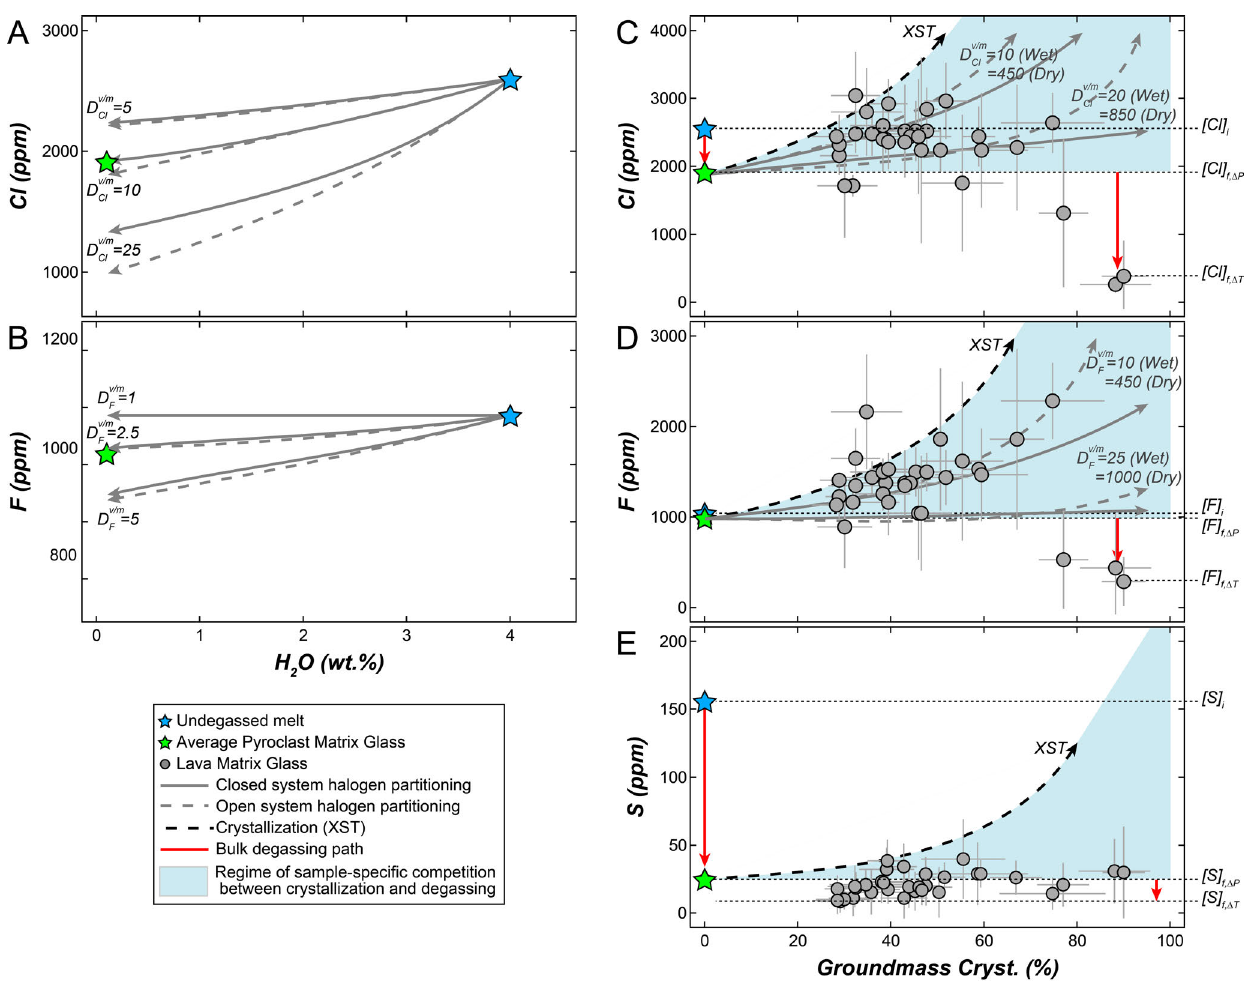
Figure 7: Devolatilisation of Cordón Caulle magma. [A–B] Partitioning of Cl and F into aqueous fluids during isothermal decompression under closed (solid lines) and open (dashed lines) exsolution of H . Initial H O content is from melt inclusion maxima in the literature [Jay et al. 2014], and final H D v/m 2 X mated to be 0.1 wt.% for all magma [Castro et al. 2014]. [C–E] Volatile loss extended to include isobaric crystalli- sation. Red arrows show magnitude of devolatilisation during decompression and crystallisation. Black dashed arrows show path of volatile incompatibility without being lost from residual melt, and the blue fields mark a re- gion of competition between incompatibility and loss. Models for halogen partitioning during crystallisation are rendered useless by the vast range of aqueous fluid availability that could be assumed. The high-crystallinity lava samples are significantly degassed in Cl and F, and are considered to be representative of most of the flow vol- ume. Sulphur appears to continue to degas, rather than behave incompatibly, across a full range of groundmass